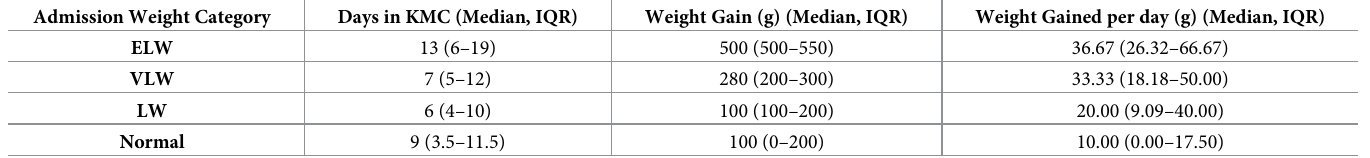
Table 4. Impact of length of stay on weight gain among